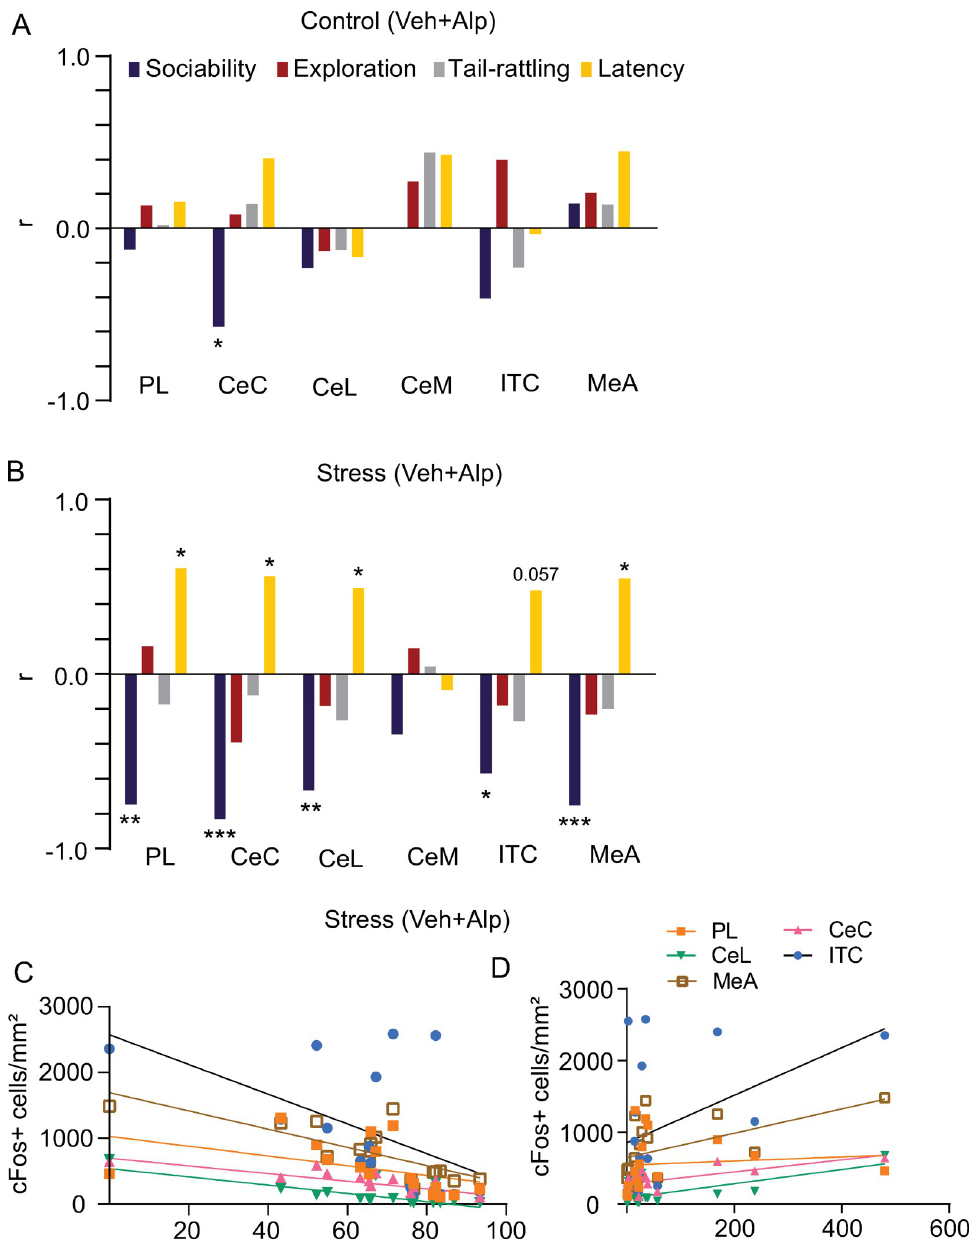
Fig 3. Correlations between behavioral variables and cFos expression. Spearman’s correlation coefficients (r) between the number of cFos+ cells and behavioral parameters in PL, CeA subdivisions, ITC and MeA of vehicle (Veh) or alprazolam (Alp) treated mice pooled together in the control ( A; N = 16 ) and stressed ( B; N = 16 ) groups. C, D , the distribution of correlation points for sociability and latency to approach against cFos+ cells/mm 2 . Spearman’s correlation coefficient represented with � indicating significant correlations ( � p < 0.05, �� p < 0.001; ��� p < 0.0001). CeC = capsular CeA, CeM = medial CeA, CeL = lateral CeA, ITC = ventromedial intercalated nucleus of amygdala, MeA = medial nucleus of the amygdala, PL = prelimbic